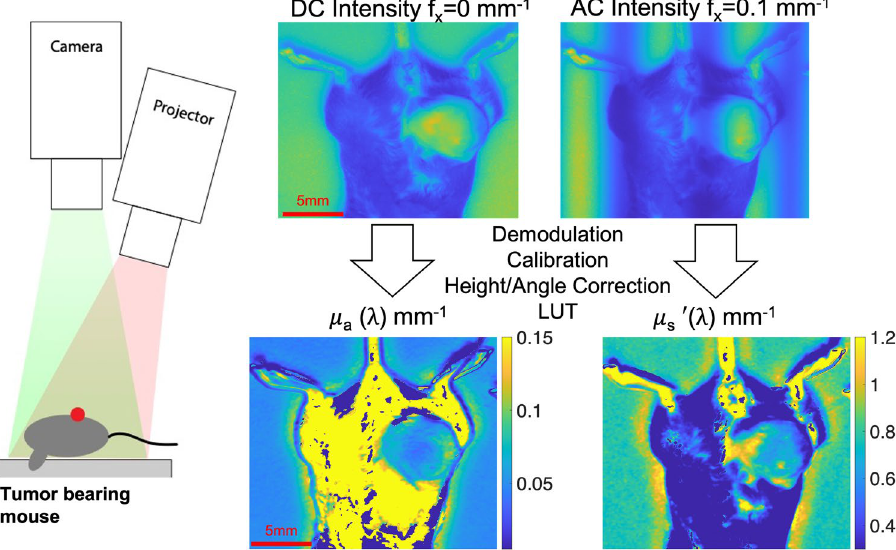
Figure 1. On the left, schematic of the SFDI system with the projector and camera. On the right is an example of intensity images at 731 nm for DC and AC (f x = 0.1 mm -1 ). These are demodulated, calibrated against a phantom, corrected for both height and angle, and then fit to a two-layer lookup table to calculate the optical properties: μ a and μ ′ s